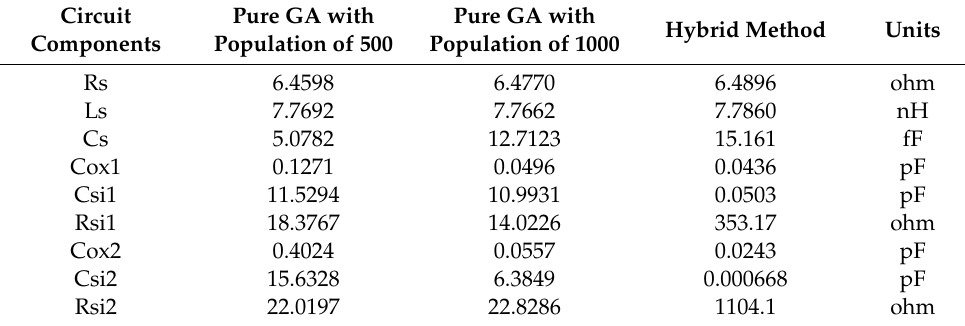
Table 3. Result of planar spiral inductor parameters extraction.